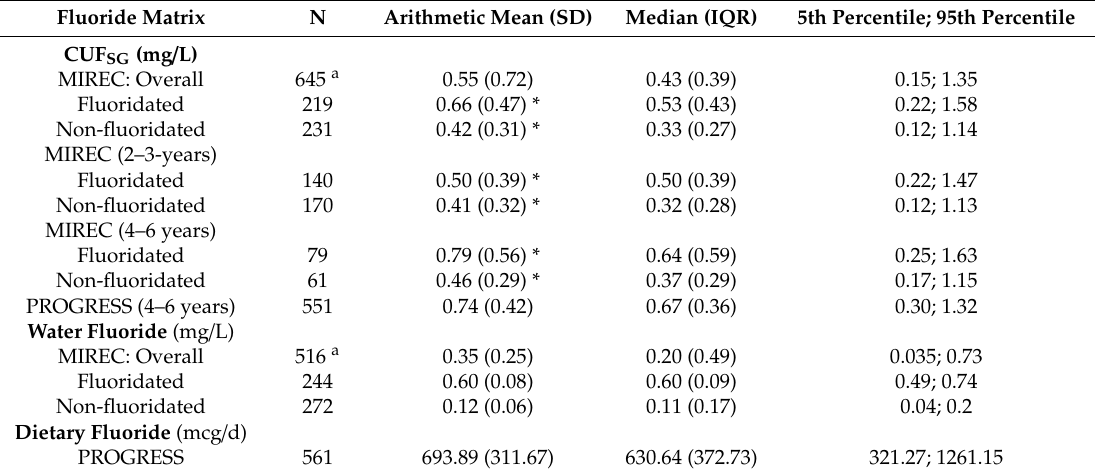
Table 2. Descriptive statistics for childhood urinary fluoride (CUF), water fluoride, and dietary fluoride levels in the MIREC and PROGRESS